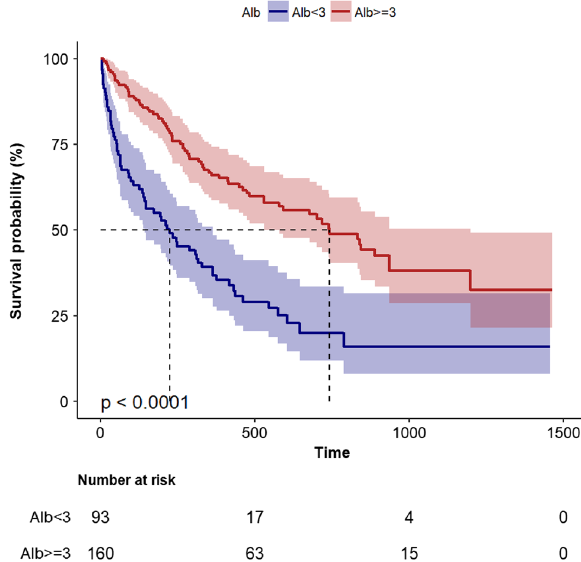
Figure 1. Kaplan Meier curve of time to death during follow-up.